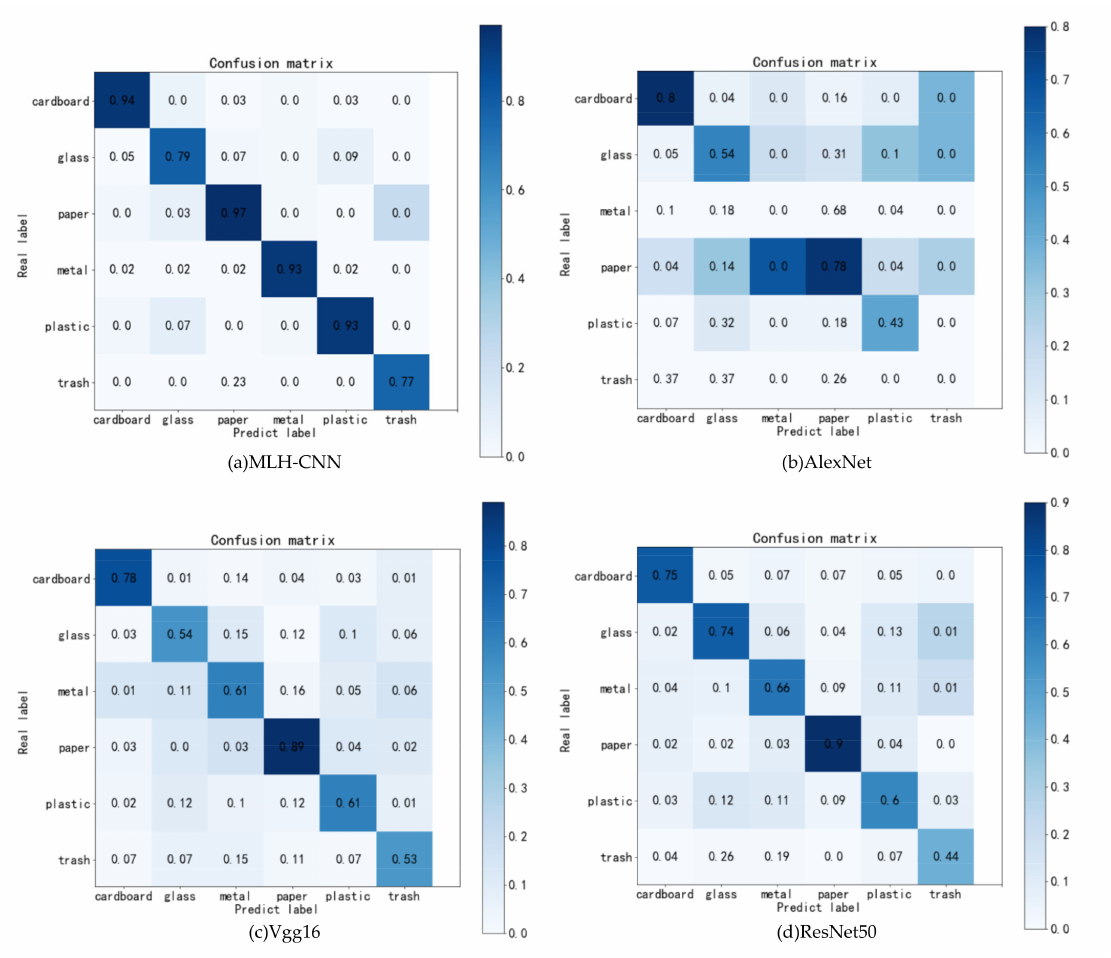
Figure 9. The confusion matrix of different